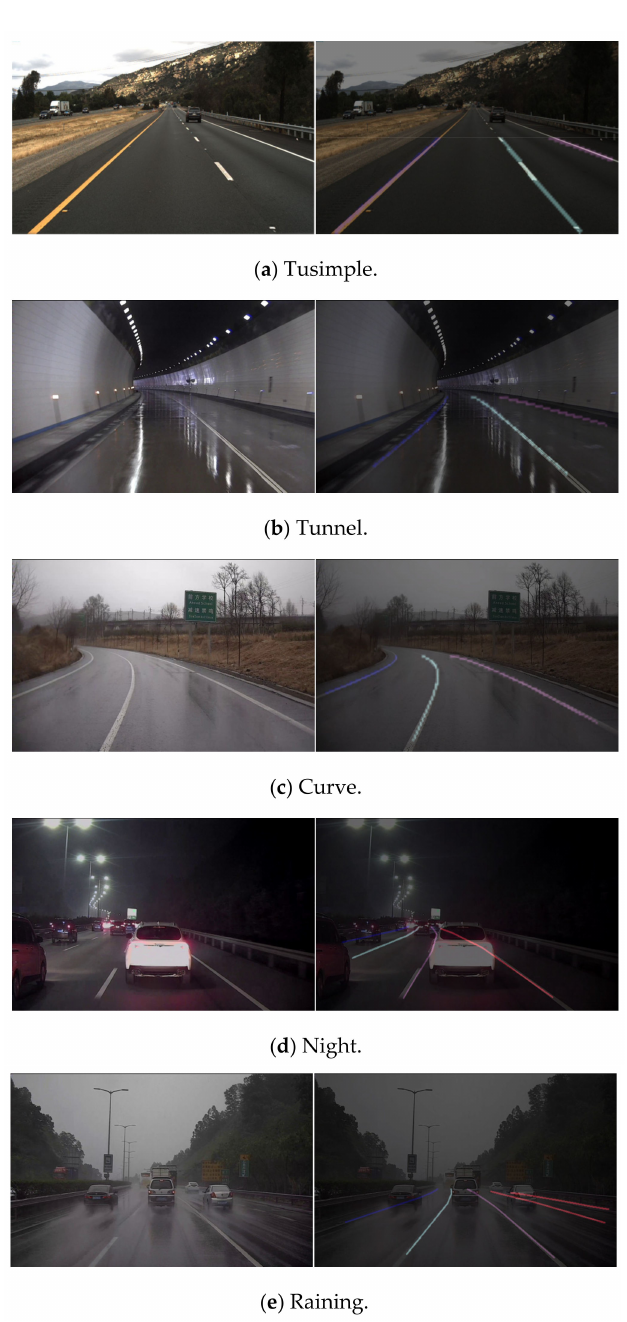
Figure 15. Effect of lane